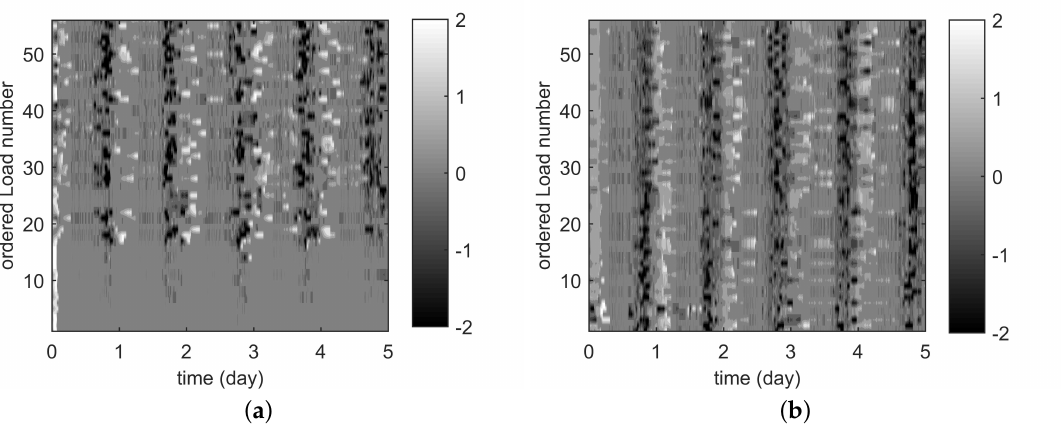
Figure 13. Battery power profiles of each load’s battery storage device over four days for ( a ) AIMD and ( b ) AIMD+. ( a ) Case C, 60% EV and 100% AIMD (kW); ( b ) Case D, 60% EV and 100% AIMD+ (kW).